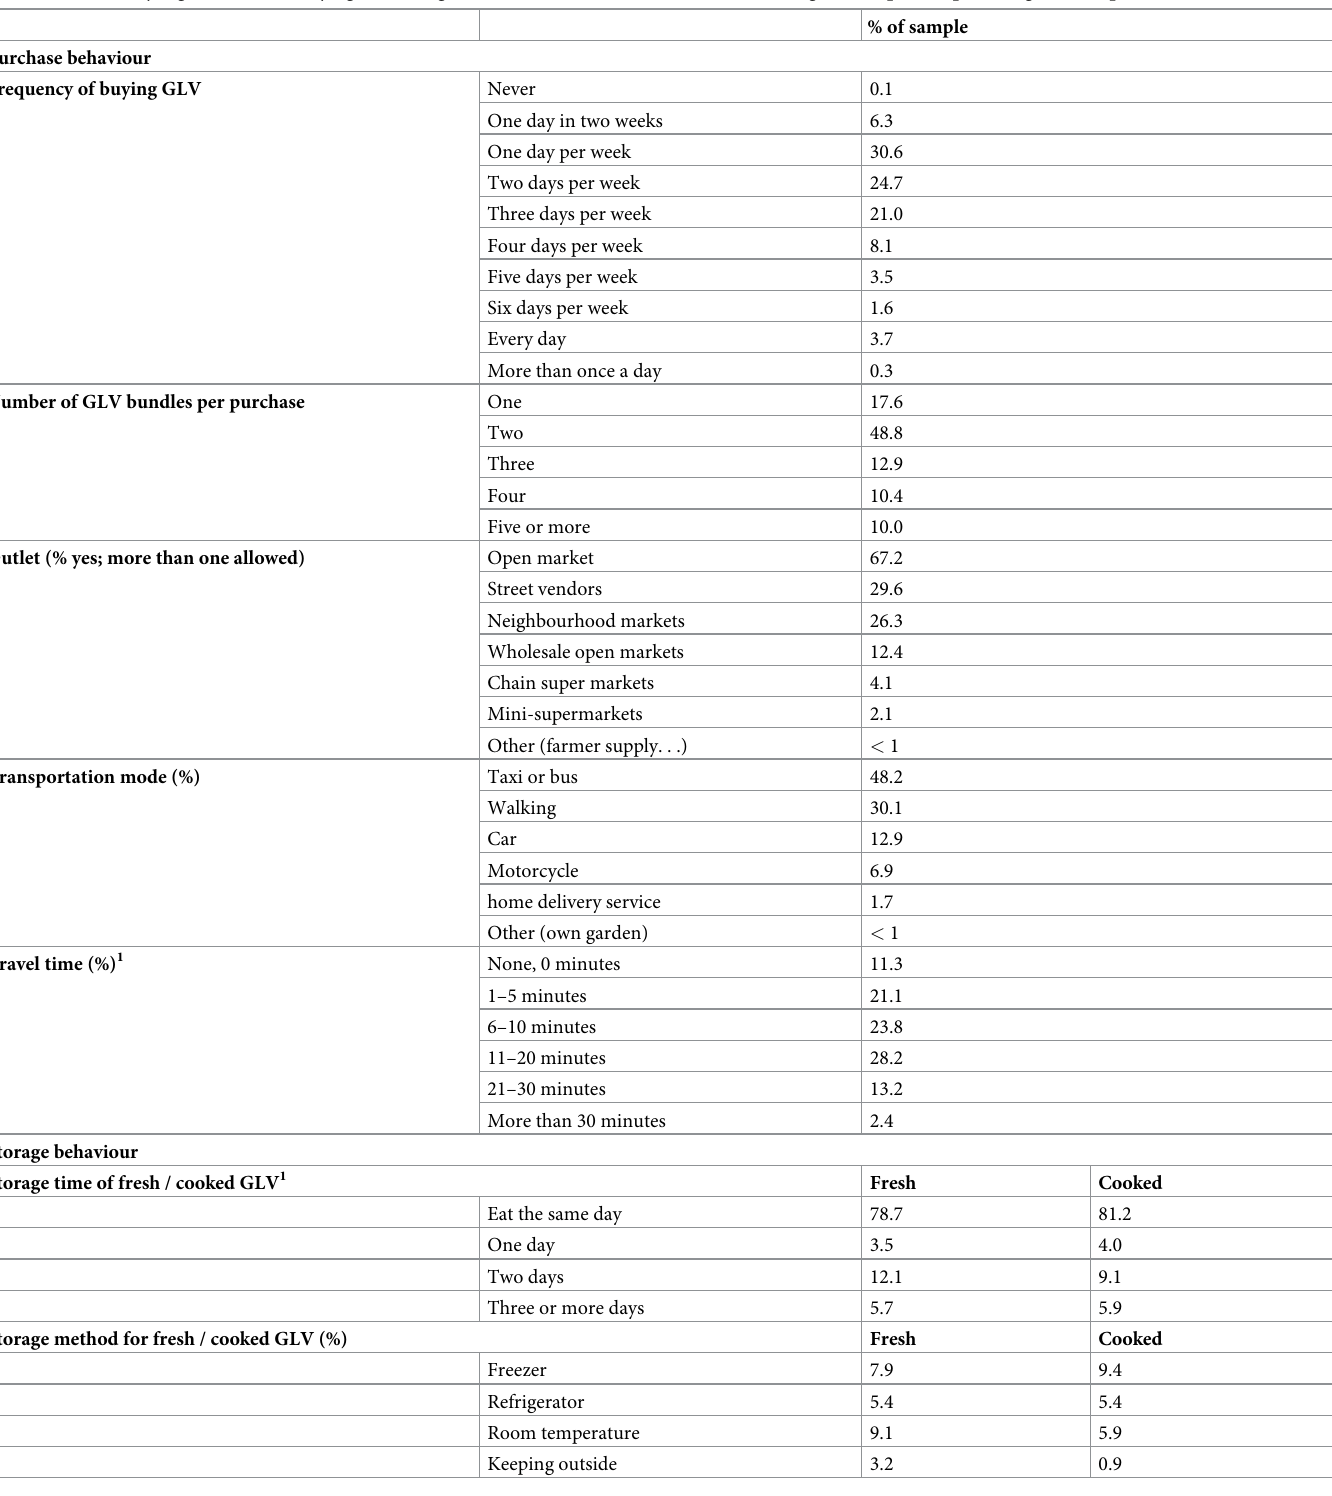
Table 3. Green leafy vegetable (GLV) buying and storage behaviour at FUTA and Secretariats during control period (percentages of sample n = 680).